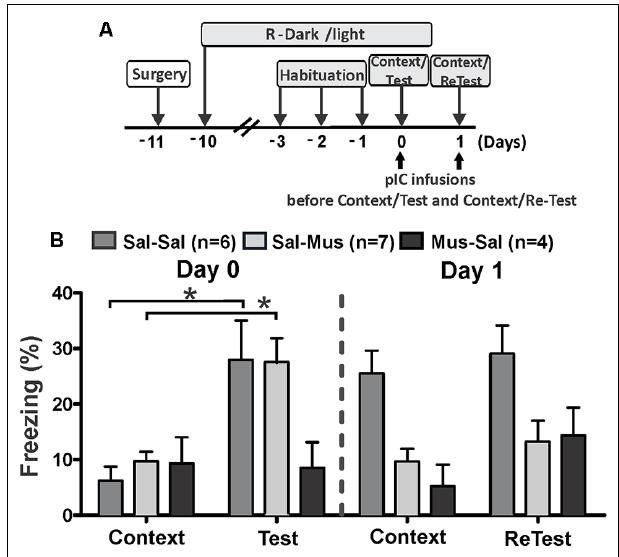
FIGURE 3 | Muscimol inactivation of the pIC prevented contextual threat learning. (A) Timeline of the experimental design. Rats were first exposed to a control collar (Context) for 10 min and then exposed to cat odor (Test, ReTest) for an additional period of 10 min. Rats received saline or muscimol into the pIC 30 min before testing (Day 0). Next day (Day 1), rats that were injected with saline on Day 0 received a second saline or muscimol injection into the pIC 30 min before testing. Similarly, rats that received muscimol on day 0 were injected with saline into pIC 30 min before testing. (B) The bars show the percentage of time spent freezing. Data are expressed as means + SEM. ∗ p <